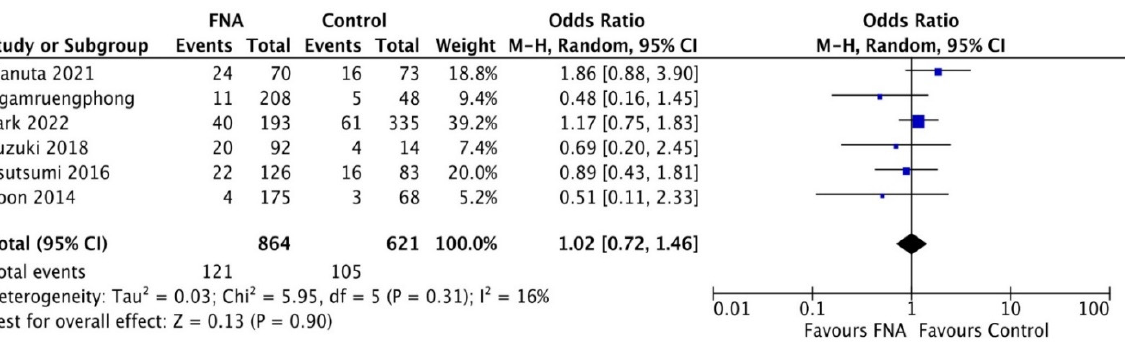
Figure 3. Funnel plot concerning the risk of publication bias.